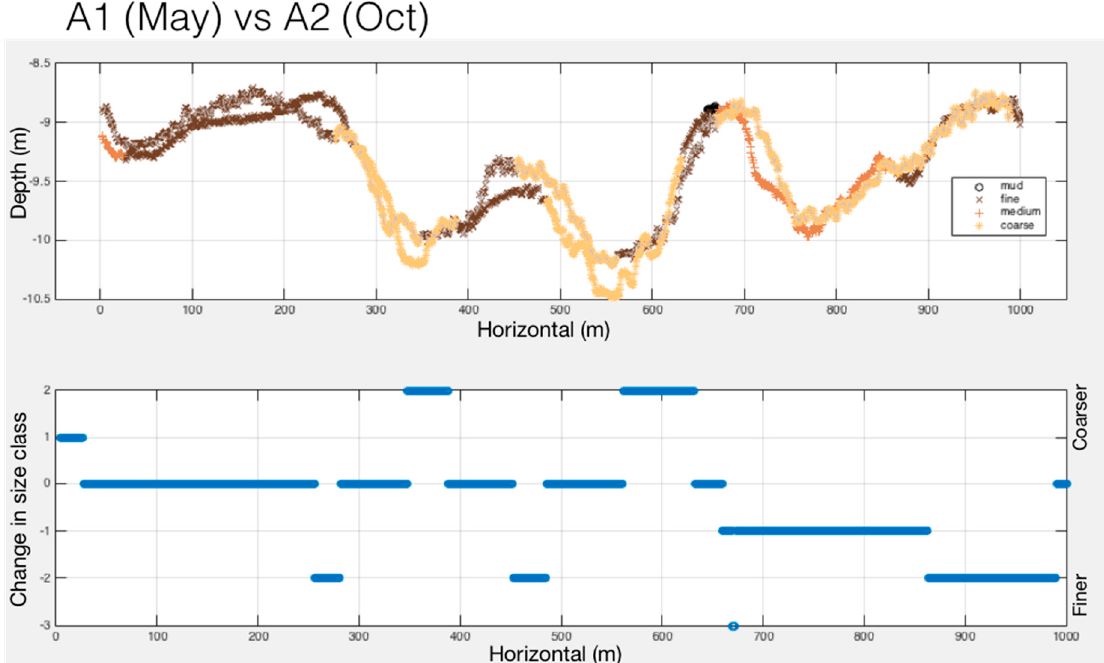
Figure 20. Bathymetry profile change versus sediment class boundary shift after Hurricane Joaquin.